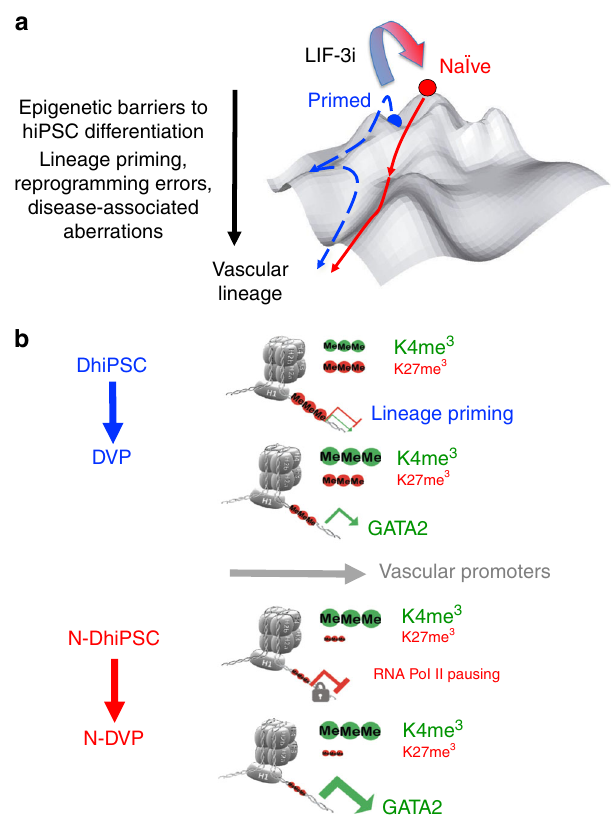
Fig. 10 Epigenetic model for improvement of multi-lineage differentiation by reversion of primed hiPSC to a naïve pluripotent state. a Waddington landscape model 70 for the epigenetic barriers posed by lineage priming, incomplete reprogramming, and disease-associated epigenetic aberrations in primed hiPSC (blue). These obstacles may be overcome with molecular reversion to a tankyrase/PARP inhibitor-regulated naïve epiblast-like state (red) possessing a developmentally naïve epigenetic con fi guration. b Compared to lineage-primed DhiPSC, N-DhiPSC possessed a de- repressed naïve epiblast-like epigenetic con fi guration at bivalent PRC2- regulated developmental promoters that was highly poised for non-biased, multi-lineage lineage speci fi